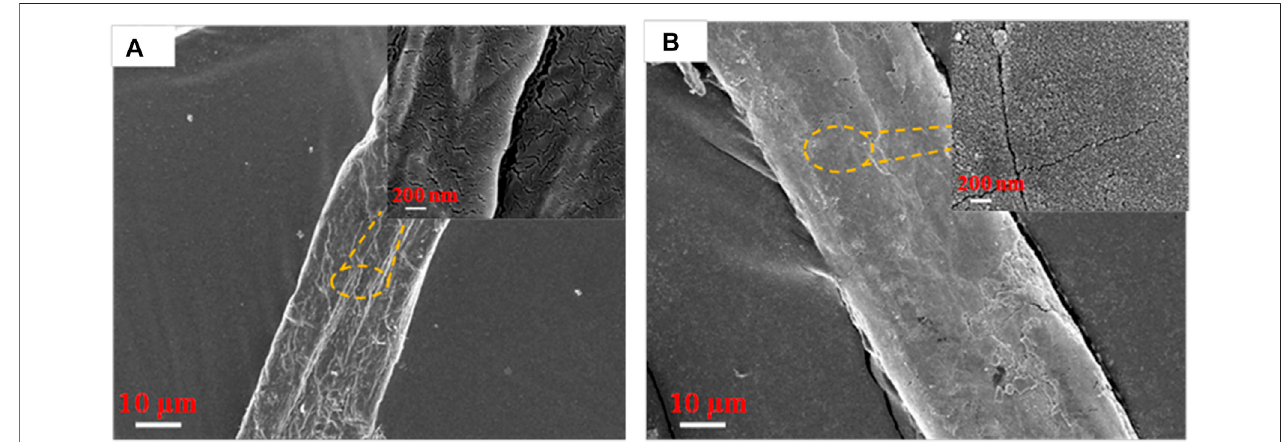
FIGURE 2 | SEM images of fi ber surface: (A) DP and (B) MDP@PDA fi bers.